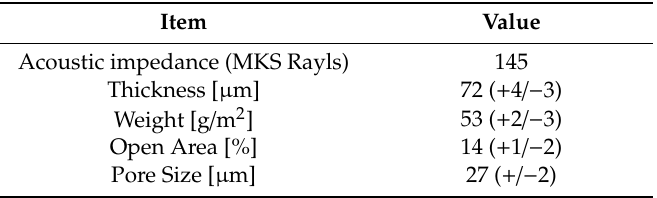
Table 2. Screen specification (by SAATI S.p.A).